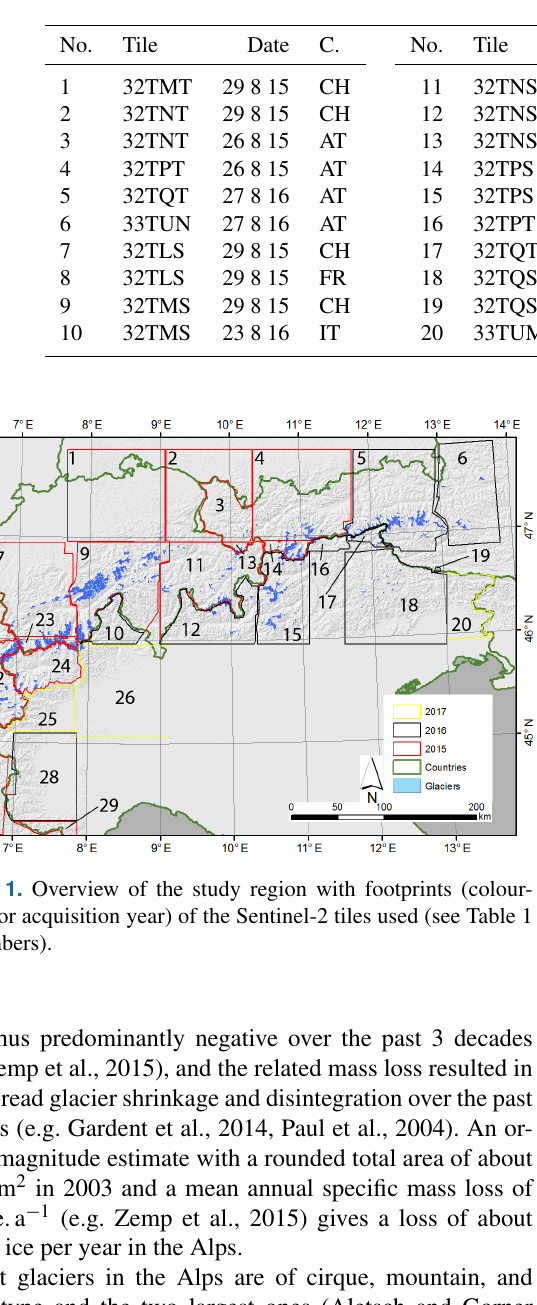
Table 1. Details about the Sentinel-2 tiles used to create the inventory; C stands for country. The related Fig. 1 shows where the tiles are located.